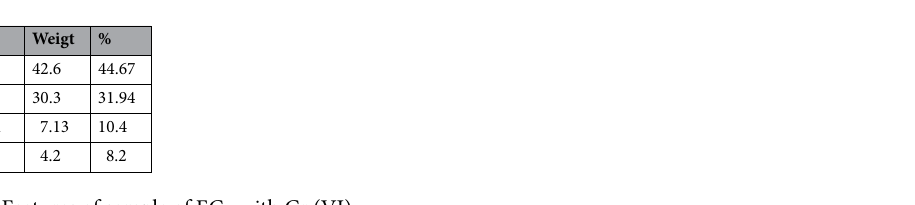
Table 3. Features of sample of ECx with Cr